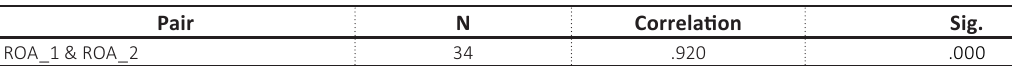
Table A7. Paired samples correlations (the result of H2b )